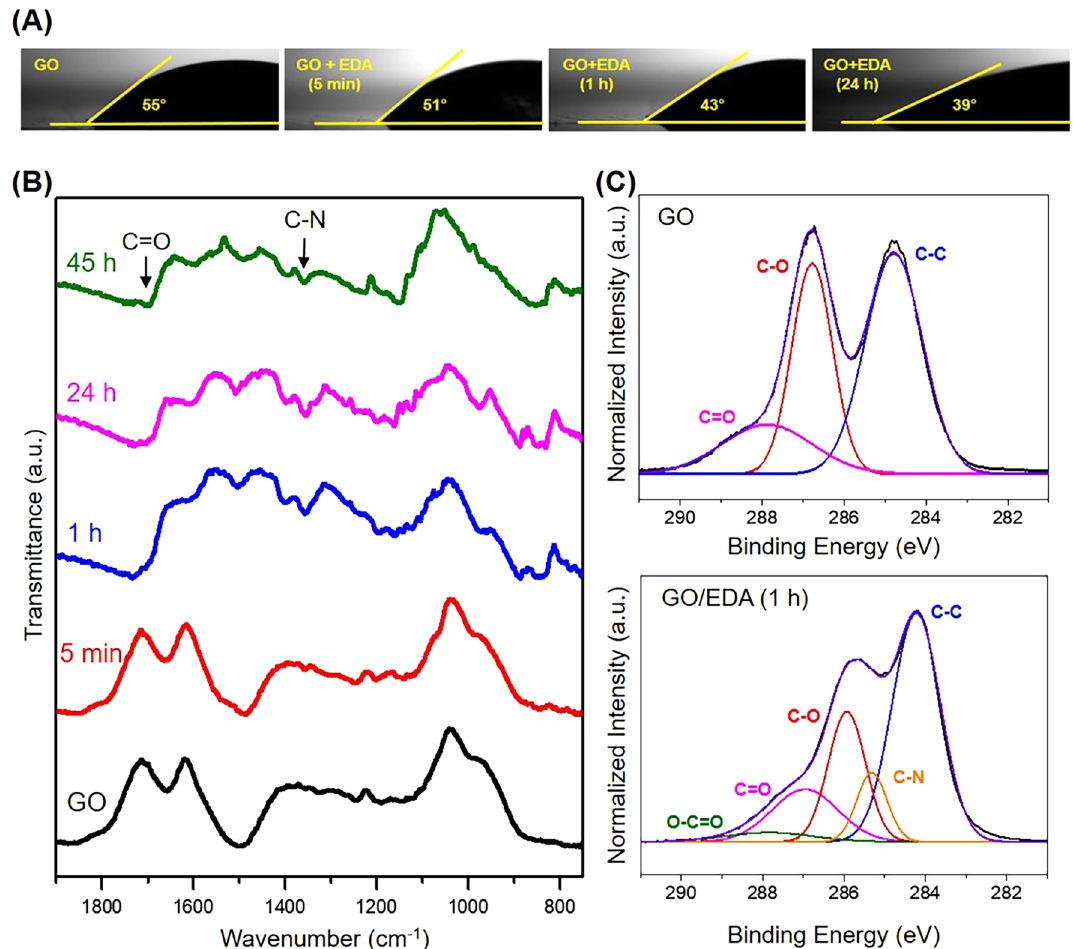
Figure 4. ( A ) Water contact angles and ( B ) FT-IR spectra of GO and GO/EDA film depending on the EDA exposure time. ( C ) XPS C1s spectra of GO and GO/EDA. EDA was exposed for 1 of GO form an amide bond 33 . At the same time, the C–N stretching peak began to appear, which implies the presence of EDA molecules in the GO/EDA coating. Figure 4C shows the C1s spectra of GO and GO/EDA coating. Typical oxygen-containing groups of C–O (286.8 eV) and C=O (287.9 eV) were detected in the circumstance of the GO coating. A new C–N peak appeared at 285.3 eV after EDA treatment due to the presence of both unreacted amine groups and the amide bonding of EDA. Also, the intensity of the C–O and C=O peaks in the XPS spectra of GO/EDA (1 h) was relatively lower compared to that of the GO peaks because of the partial reduction of oxygen groups in the presence of the alka- line EDA 40 . The reduction mechanism can be a nucleophilic ring-opening reaction in the presence of amines, which means that the amine groups disconnect the oxygen moieties and remain sp 2 hybridized carbon bonding 41 . This partial reduction reaction between GO and EDA was reconfirmed by the Raman spectra, which showed an increased I D /I G ratio as the EDA exposure time increased (Supplementary Fig. S5). It is known that the I D /I G peak ratio of GO increases by chemical reduction due to the generation of dense and small sp 2 carbon domains 21 .